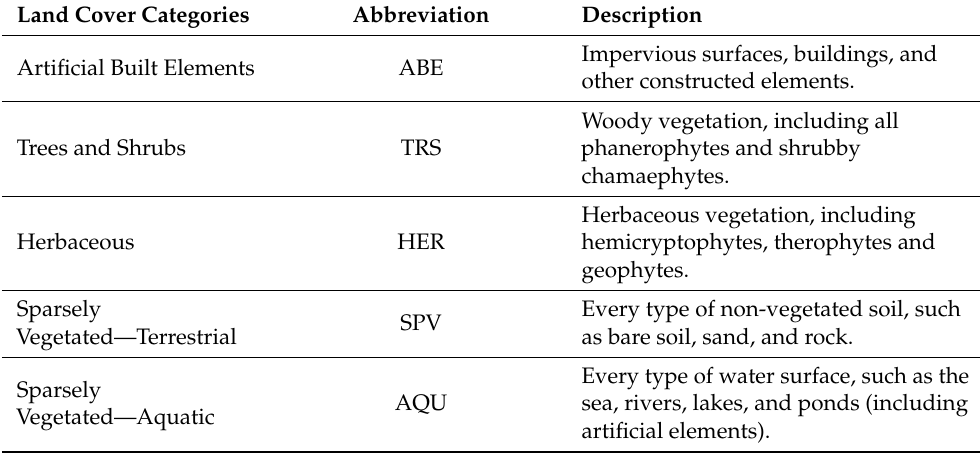
Table 1. Land cover categories (adapted from